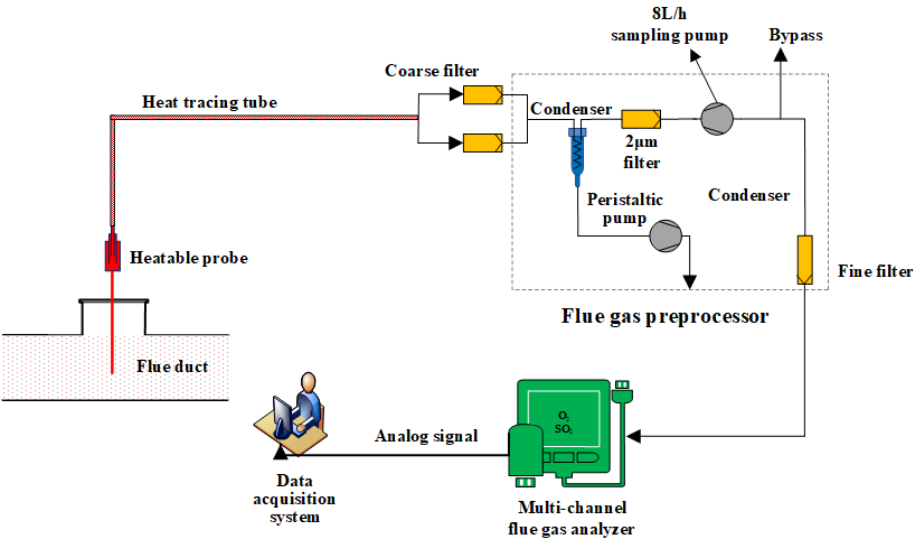
Figure 2. System diagram of SO 2 sampling and analysis.